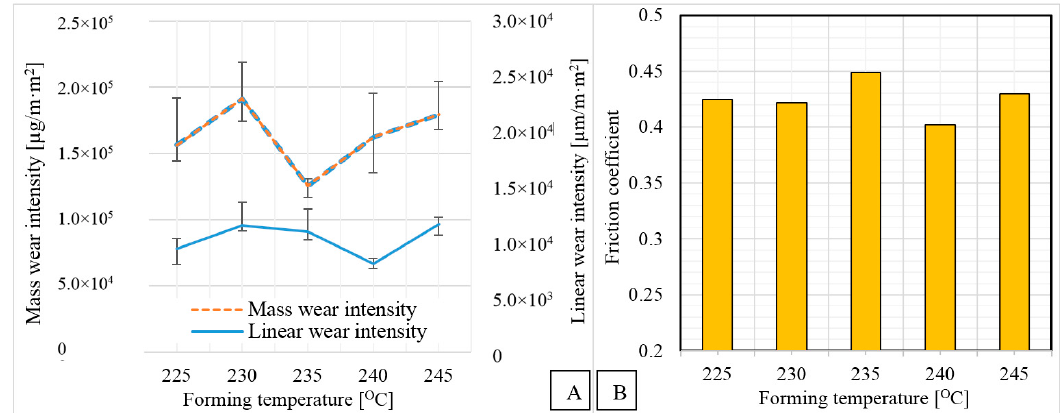
Figure 8. ( A ) Intensity of mass and linear wear, ( B ) coefficient of friction at different composite forming temperatures.